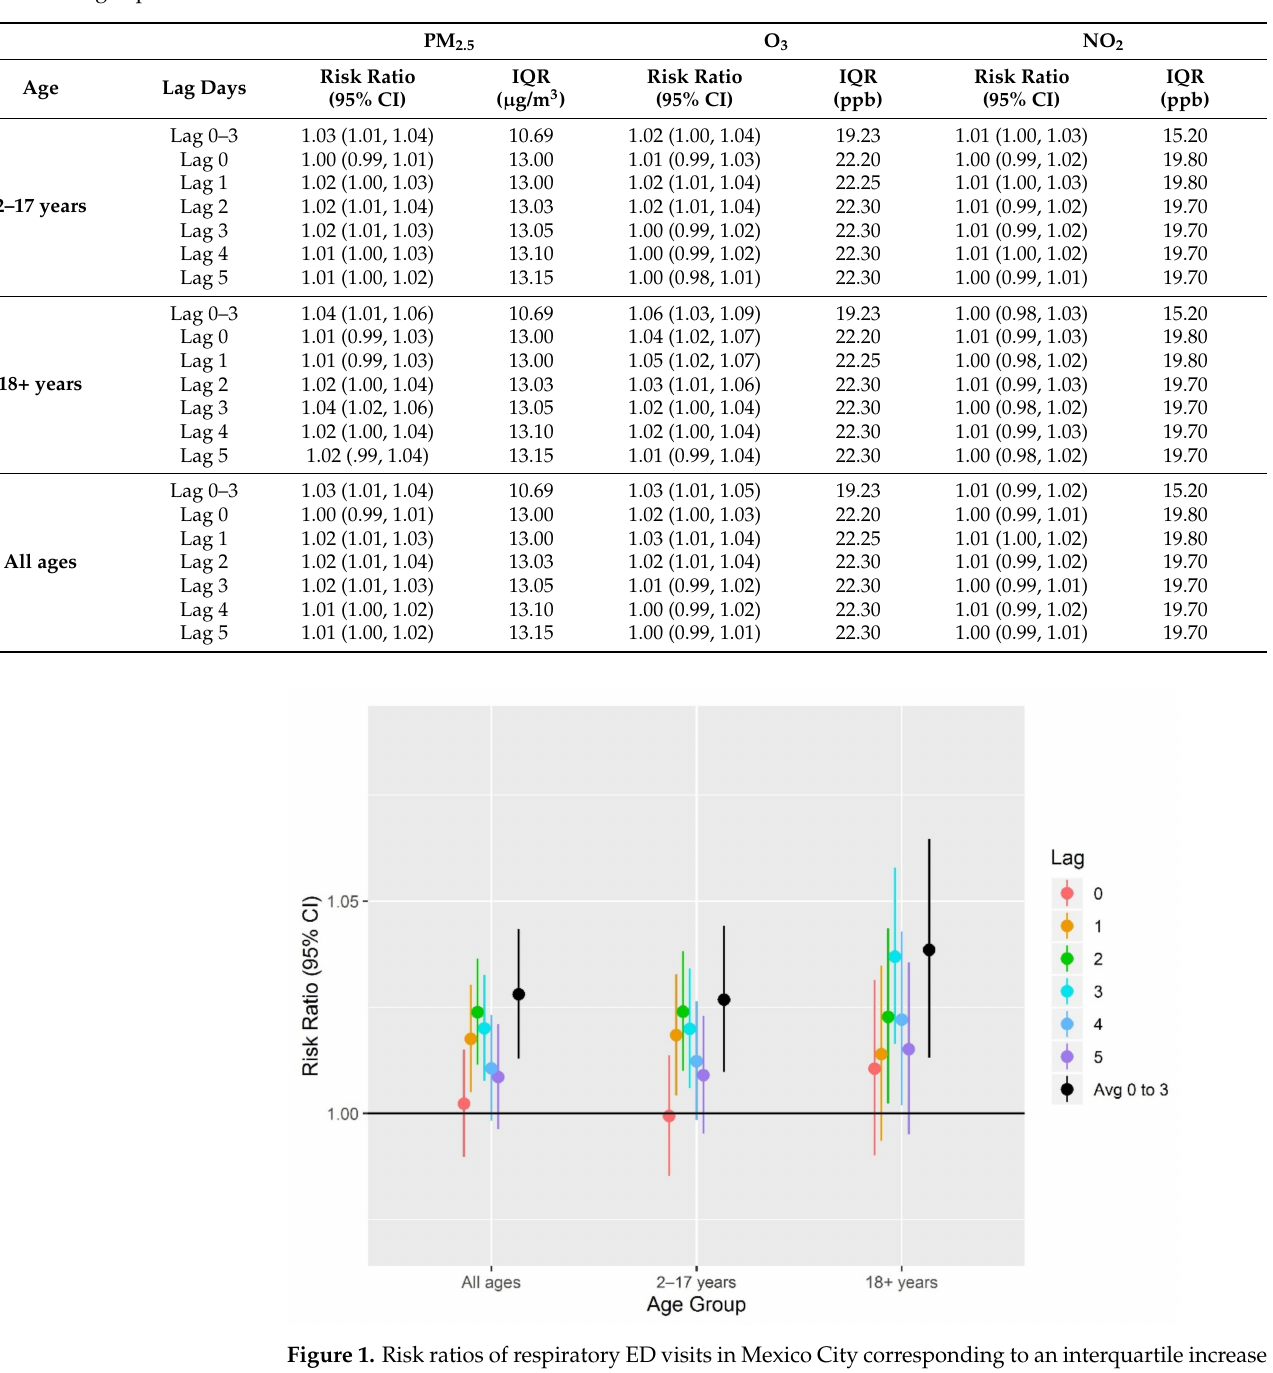
Table 2. Risk ratios (per interquartile range, or IQR) of respiratory emergency department visits in Mexico City associated with key pollutants [fine particulate matter (PM 2.5 ); ground-level ozone (O 3 ); and nitrogen dioxide (NO 2 )], by age group and lag structure. Significant positive associations for population-level respiratory health risk is most consistently observed for PM 2.5 and O 3 . Average lag structures were able to capture effects that were observed to occur over multiple days following exposure.